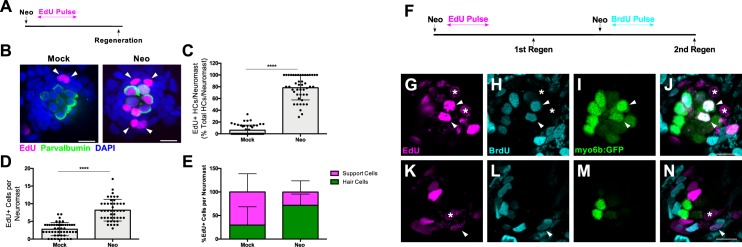
Hair cell progenitors are replenished via proliferation of other support cells.(A, F) Timelines of single-ablation (A) and double-ablation (F) proliferation experiments. (B) Maximum projections of mock- (Mock) and neomycin-treated (Neo) neuromasts. EdU-positive cells are shown in magenta, anti-Parvalbumin-stained hair cells are shown in green, and DAPI-stained nuclei are shown in blue. Arrowheads indicate EdU-positive support cells. Scale bar = 10 μm. (C) Percentage of hair cells per neuromast labeled by EdU. Mock: 6.11 ± 8.69, n = 50 neuromasts (10 fish); Neo: 78.24 ± 20.69, n = 45 neuromasts (nine fish); mean ± SD; Mann Whitney U test, p<0.0001. (D) Total EdU-positive cells per neuromast. Mock: 2.78 ± 1.84, n = 50 neuromasts (10 fish); Neo: 8.18 ± 3.07, n = 45 neuromasts (nine fish); mean ± SD; Mann Whitney U test, p<0.0001. (E) Percentage of EdU-positive cells per neuromast that are either hair cells or support cells. Mock: 29.73% hair cells, 70.27% support cells, n = 50 neuromasts (10 fish); Neo: 72.02% hair cells, 27.98% support cells, n = 45 neuromasts (nine fish); mean ± SD. (G–N) Individual slices of a neuromast following two regenerations at two different planes: apical hair cell layer (G–J) and basal support cell layer (K–N). EdU (visualized by a Click-iT reaction) is labeled in magenta, BrdU (anti-BrdU) is labeled in cyan, and myo6b:GFP hair cells are labeled in green. Arrowheads indicate EdU/BrdU-positive hair cells, and asterisks indicate EdU-positive support cells. Scale bar = 10 μm.10.7554/eLife.43736.004Figure 1—source data 1.Hair cell progenitors are replenished via proliferation of other support cells